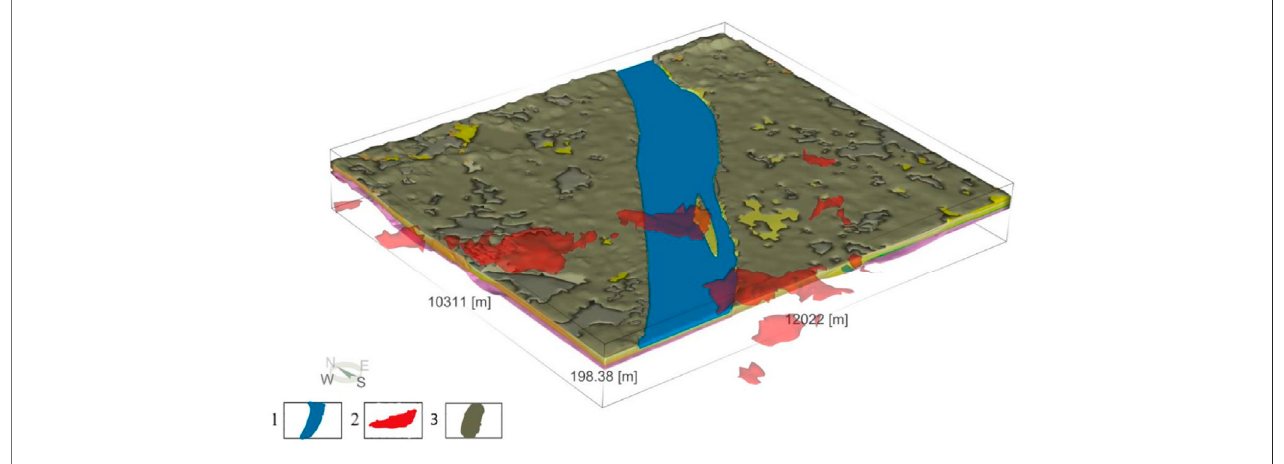
FIGURE 2 | Diagram of karst distribution. 1. Yangtze River; 2. Carbonate rock; 3. Quaternary strata.